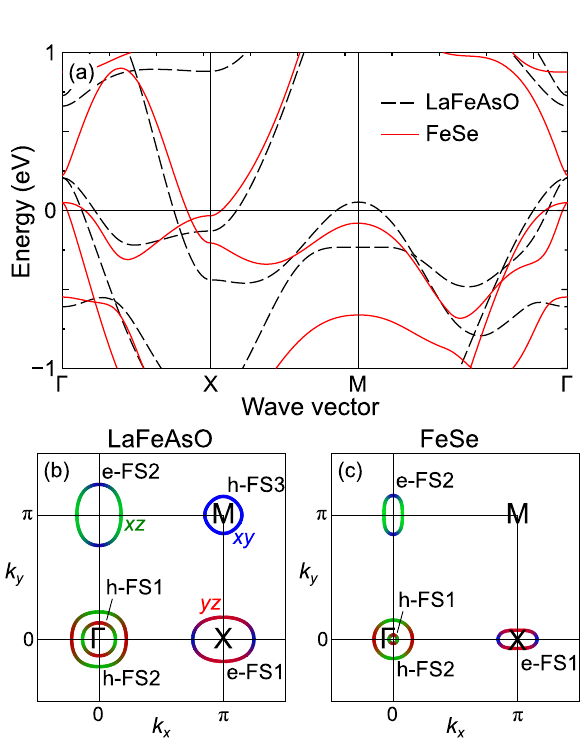
FIG. 1. (a) Band structures of the eight-orbital TB models for LaFeAsO and FeSe. (b) FSs for the LaFeAsO TB model. (c) FSs for the FeSe TB model. The colors correspond to 2 (green), 3 (red), and 4 (blue),